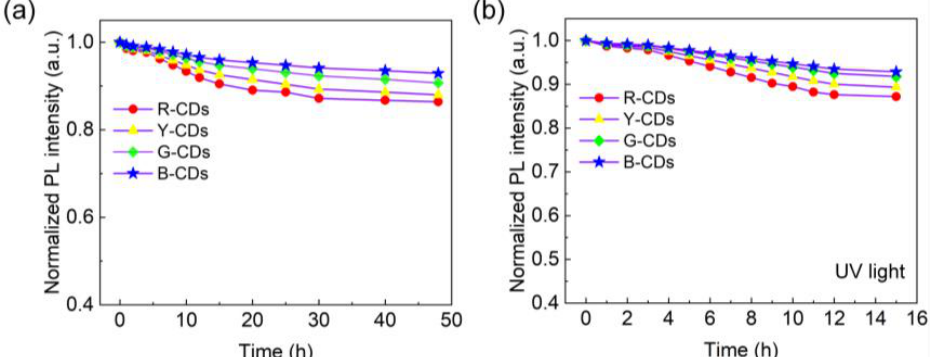
Figure 9. ( a ) Thermal stability of the R-CDs, Y-CDs, G-CDs, and B-CDs at 80 °C. ( b ) Photostability of the R-CDs, Y-CDs, G-CDs, and B-CDs under UV lamp irradiation.